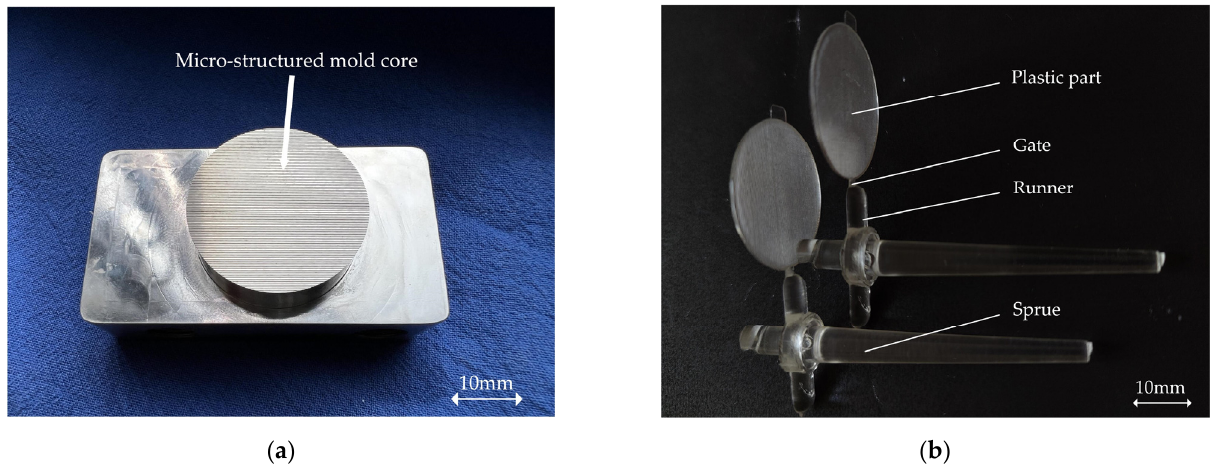
Figure 1. Photographs of the micro-structured mold core and parts: ( a ) insert with microstructure array; ( b ) injection-molded sample.